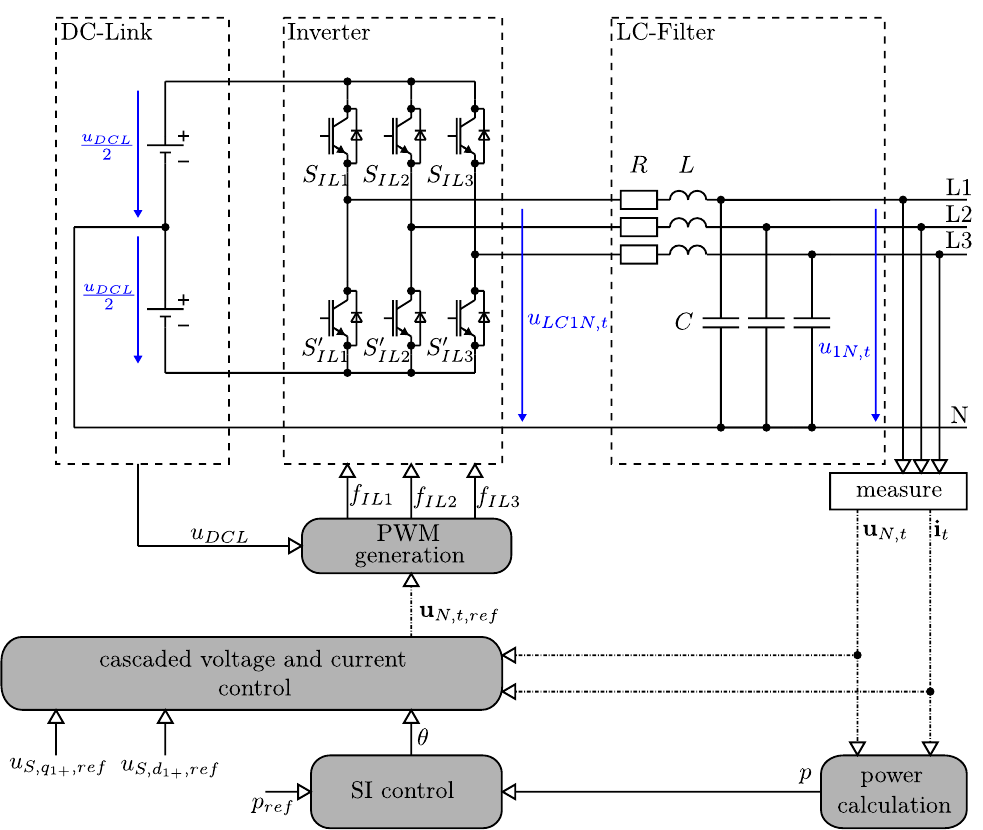
Figure 1. Model of a grid-forming converter and its control. The figure also shows relevant voltages which are marked in